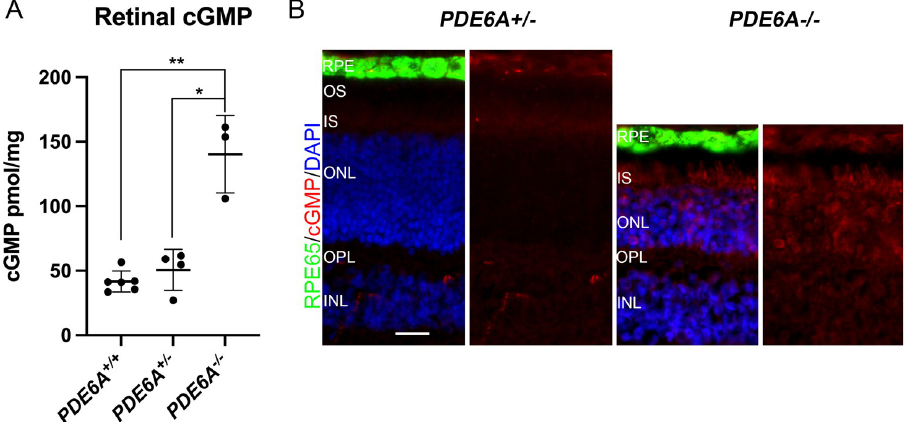
Fig 1. Retinal cGMP levels in 2-month-old animals. (A) Retinal cGMP is significantly elevated in PDE6A -/- dogs compared to PDE6A +/+ and PDE6A +/- dogs. (B) Retinal sections from PDE6A +/- and PDE6A -/- dogs showing cGMP (red) accumulation in the photoreceptors extending to include the cell bodies and synaptic terminals. For each genotype the left image shows cGMP (red), RPE cells (green) and DAPI nuclear counterstain (blue) and right image